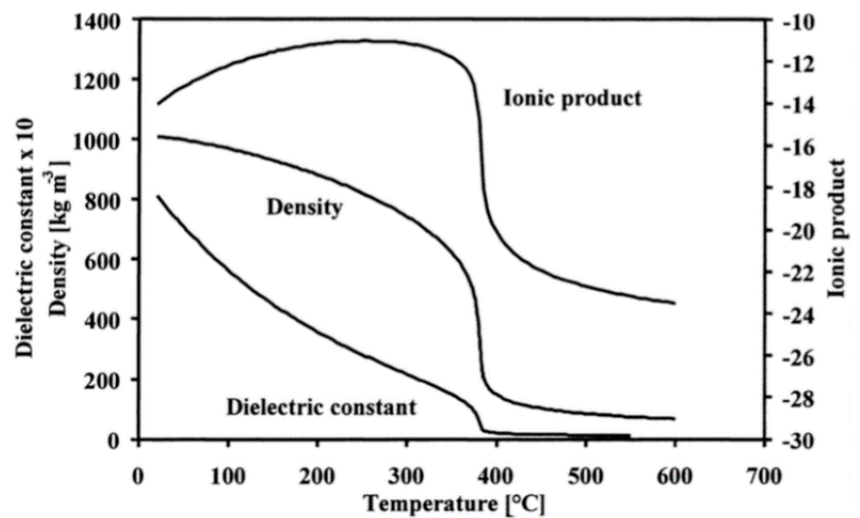
Figure 37. Course of ionic product, density, and dielectric constant of water versus temperature at a pressure of 24 MPa. Reprinted with permission from Reference [109]. Copyright 1999 Elsevier.